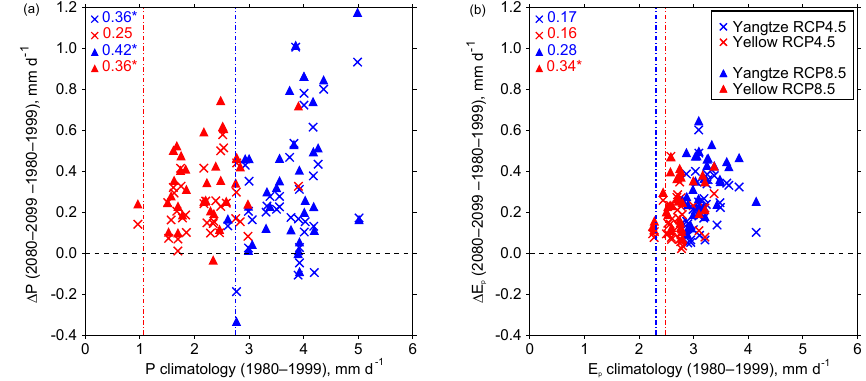
Figure 10. Future-minus-present changes (2080–2099 minus 1980–1999) in P (a) and E p (b) against P and E p climatologies (1980–1999), respectively, for 34 CMIP5 models. The dashed vertical lines show the observed climatologies for the Yellow (red) and Yangtze (blue) River catchments. The values in the top left of each panel refer to correlation coefficients for the catchment and RCP emissions scenario listed in the legend. Those with asterisks are significant at the 95% ( p = 0 . 05) confidence level.